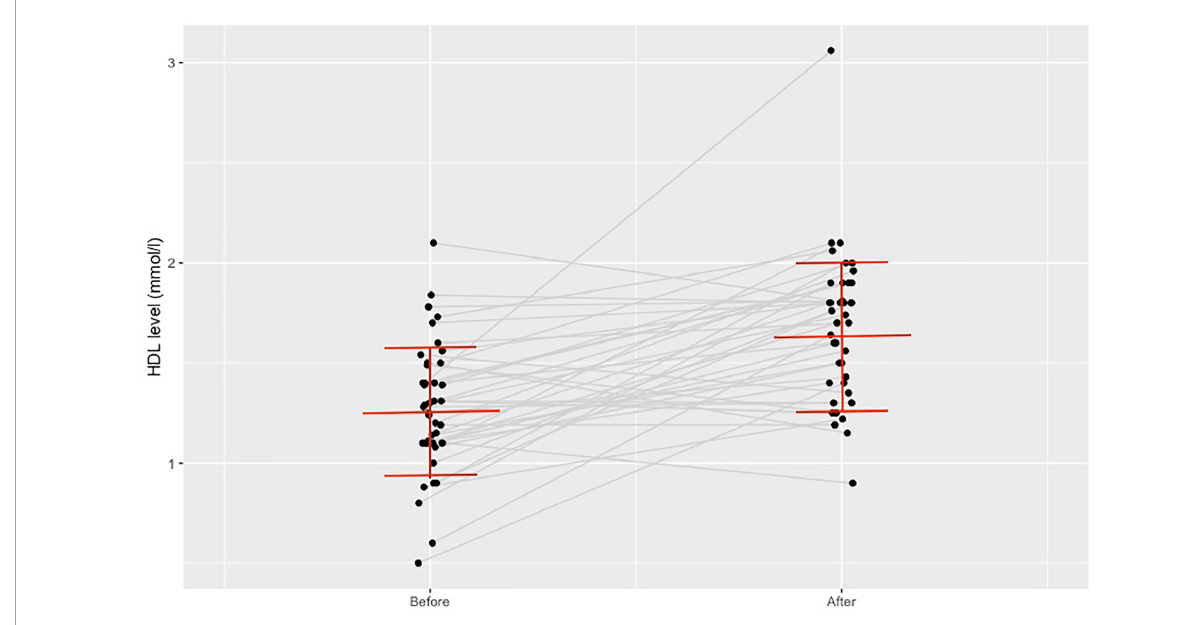
FIGURE3 Change in high-density lipoprotein-cholesterol level before and after the training program.